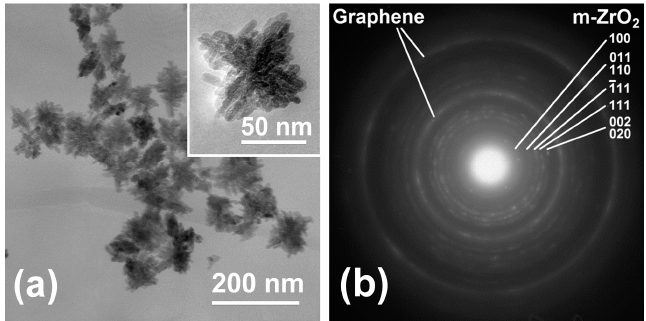
Figure 2. Transmission electron microscopy (TEM) image of ( a ) zirconia nanostars, and ( b ) their electron diffraction picture.